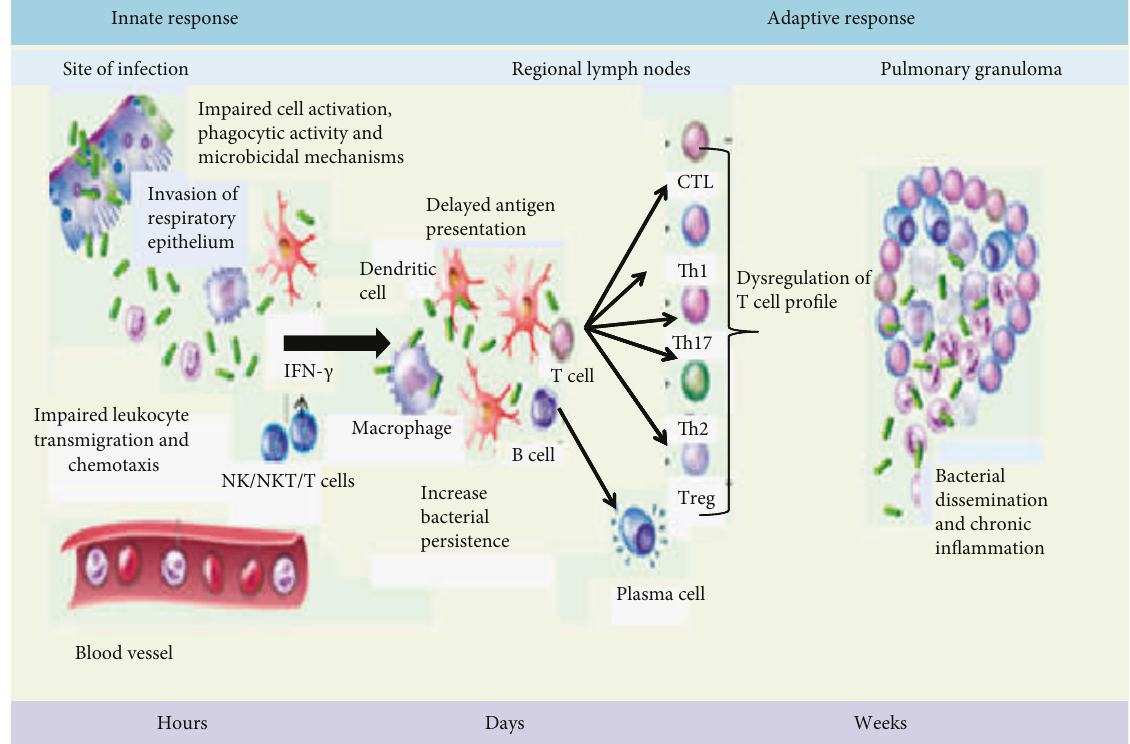
Figure 1: The putative immune mechanisms contributing to the increased susceptibility of diabetic hosts to Mycobacterium